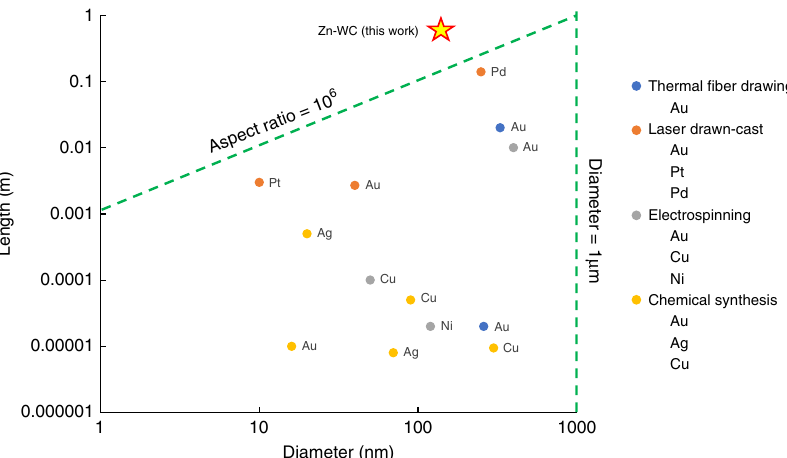
Fig. 4 Comparison of metal nanowires among different fabrication methods. The manufacturing methods of high-melting-temperature metal nanowires include thermal fi ber drawing, electrospinning, laser drawn-cast process, and chemical synthesis. The green dash lines indicated the limitation that such traditional methods are unable to achieve nano/submicron metal wire fabrication with an aspect ratio of >10 6 . Zn-WC has fundamentally enhanced the instability growth time to realize a much longer nanowire fabrication. Data adapted from the literature are speci fi ed in Supplementary Table